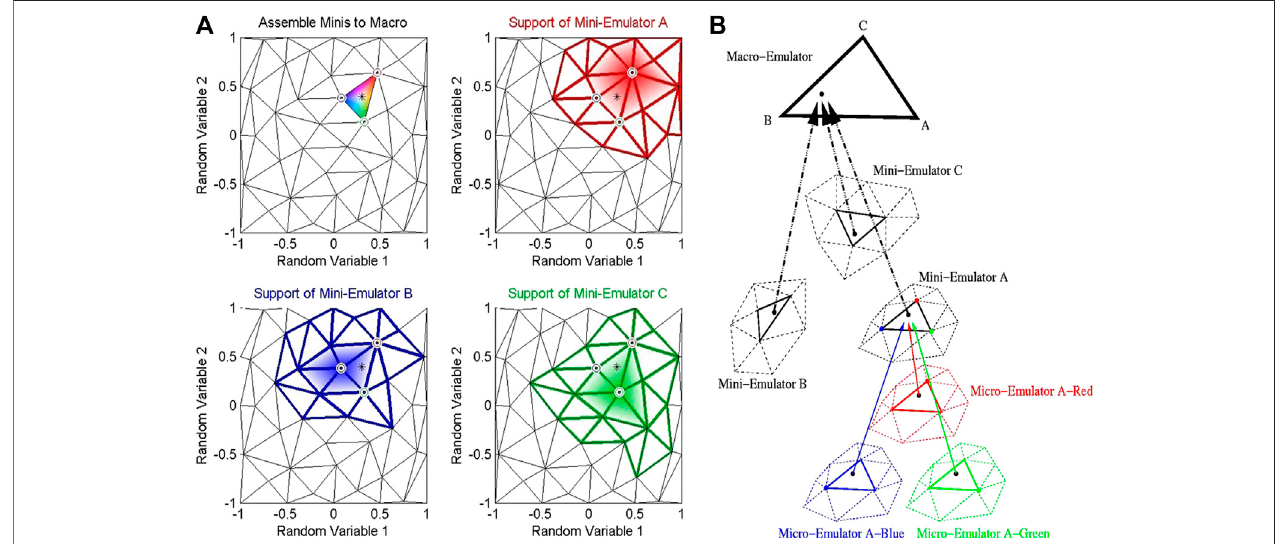
FIGURE 2 | Example mini-emulators. (A) Tessellation of the input parameter space showing micro-emulator support of mini-emulators. (B) Assembly of the hierarchy of emulators to produce the macro-emulator (Dalbey, 2009).